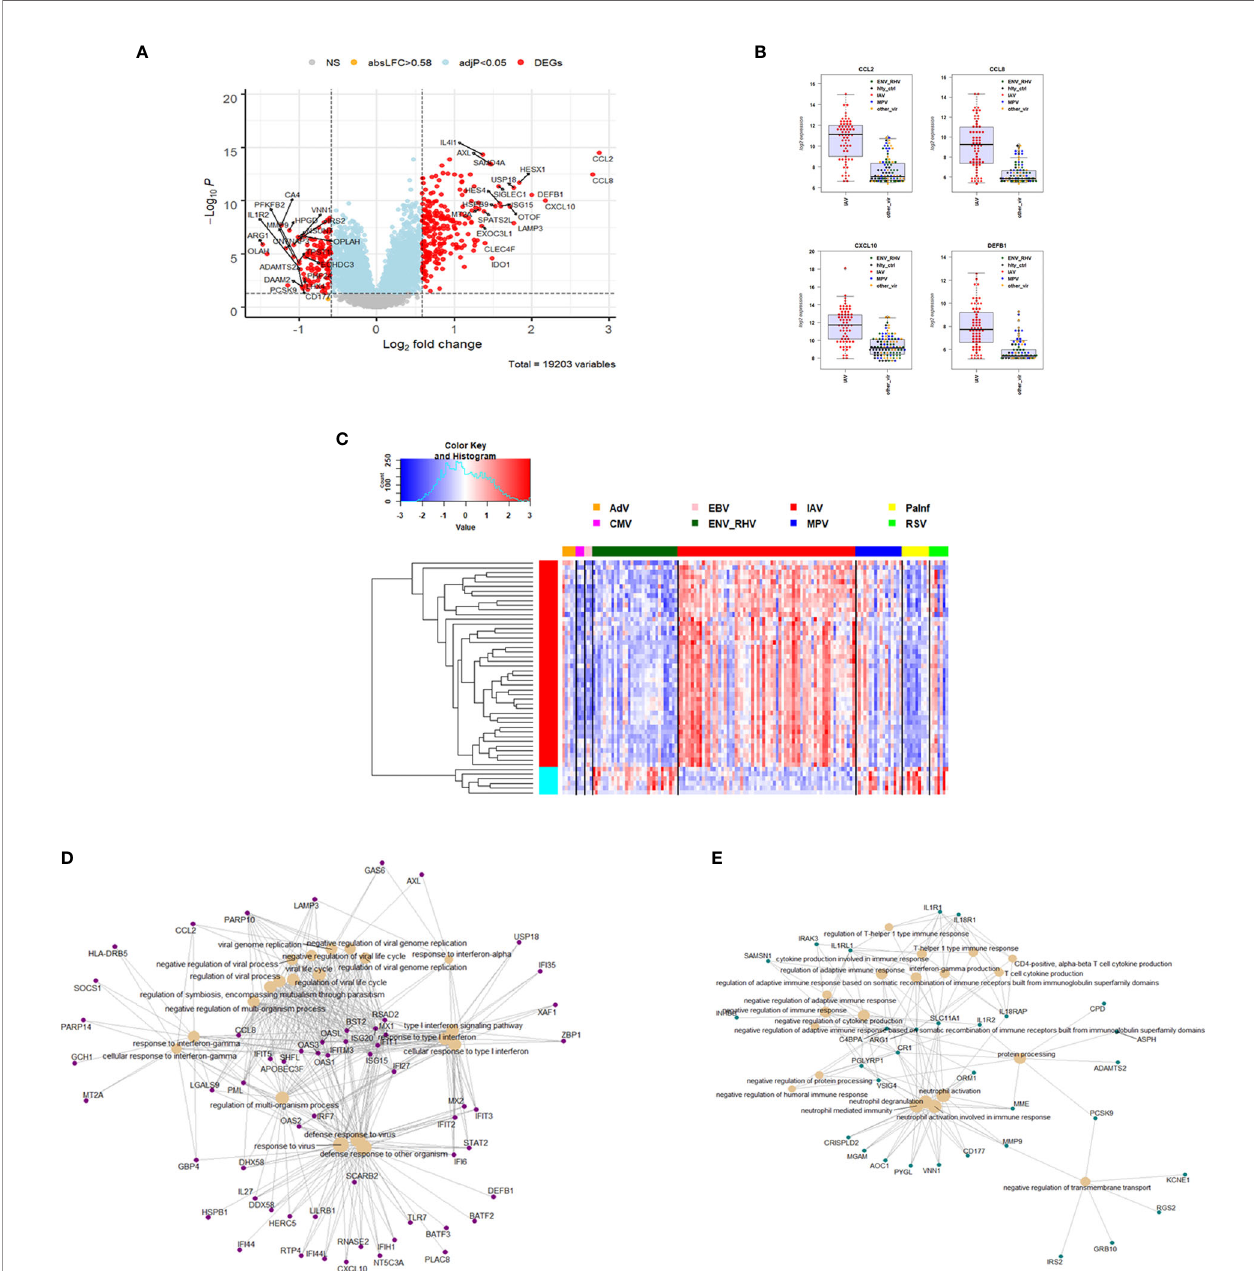
FIGURE 4 | Responses in IAV versus other respiratory infections. (A) Volcano plot of results of the contrast from the linear regression analysis of in fl uenza virus infected versus all other respiratory virus infections. y-axis: -log 10 BH multiple testing adjusted p-values, x-axis: log 2 fold change. DEGs (absolute log-fold change > 1.5, corresponding to a log 2 -fold change > 0.58; multiple testing adjusted p-value < 0.05) are colored red and the top 20 up- and down-regulated (by log-fold change) DEGs are labeled. Blue: genes with adjusted p-value < 0.05. (B) Normalized gene expression levels of the top four most strongly up-regulated (by absolute fold-change) in fl uenza virus versus all other respiratory virus speci fi c DEGs. CCL2 , C-C Motif Chemokine Ligand 2; CCL8 , C-C Motif Chemokine Ligand 8; CXCL10 , C-X-C Motif Chemokine Ligand 10; DEFB1 , Defensin Beta 1; IAV, in fl uenza; ENV_RHV, enterovirus/rhinovirus; MPV, human metapneumovirus; other_vir, all other respiratory viruses; hlty_contr, healthy controls. (C) Heatmap of expression levels of the top 50 most strongly regulated (by absolute fold-change) DEGs from the contrast of IAV infected patients versus all other respiratory infections are presented. Values were scaled by row. red: up-regulated DEGs, blue: down-regulated DEGS. IAV, in fl uenza virus; ENV_RHV, enterovirus/rhinovirus; MPV, metapneumovirus; PaInf, parain fl uenza virus; RSV, respiratory syncytial virus; AdV, adenovirus; CMV, cytomegalovirus; EBV , Epstein-Barr virus. (D) Functional analysis using GO term enrichment for the DEGs from the contrast of IAV infected versus all other respiratory virus infections. Network of top 20 up-regulated pathways and associated genes. Red: up-regulated. (E) Functional analysis using GO term enrichment for the DEGs from the contrast of IAV infected versus all other respiratory virus infections. Network of top 20 down-regulated pathways and associated genes. Green: down-regulated. NS, not signi fi